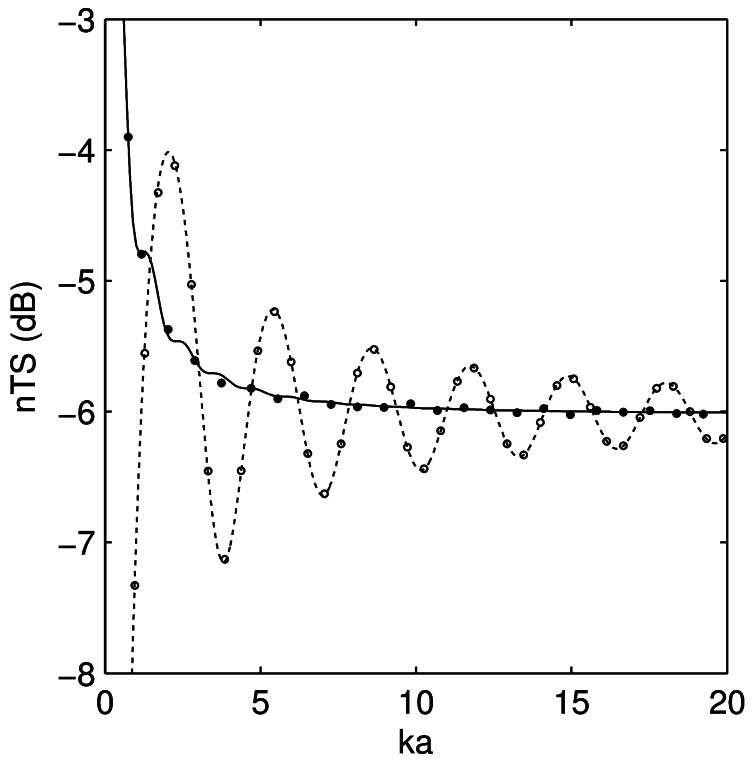
Comparison of the Kirchhoff-approximation and finite element models to exact solutions.Length-normalised target strength (nTS) of a 25 mm diameter pressure release sphere immersed in water as a function of ka, calculated using the Kirchhoff approximation model (open circles), Kirchhoff integral (dashed line), finite element model (filled circles) and series solution (solid line).